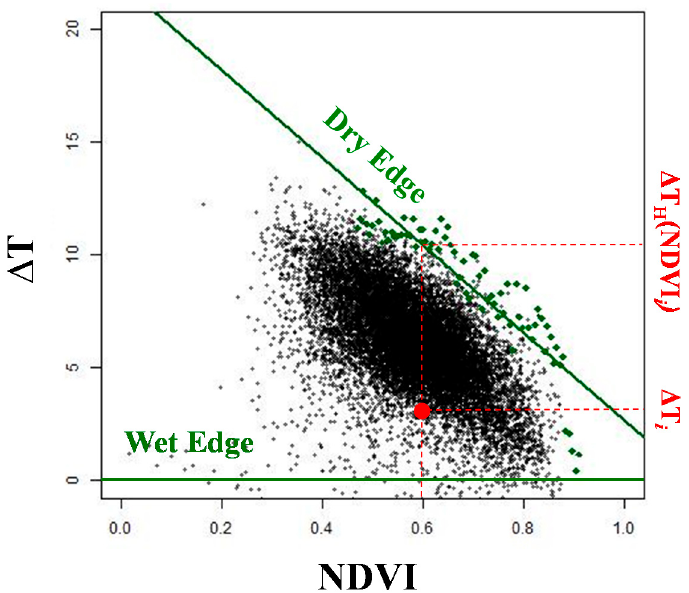
Figure 2. Example scatter plot between NDVI and ∆ T ( T s − T a ) for a given day. Green dots are maximum ∆ T values for each NDVI interval, green lines are the dry (wet) edges, ∆ T H ( NDVI i ) and ∆ T i represent the values used in the calculation of the EF for the pixel i .